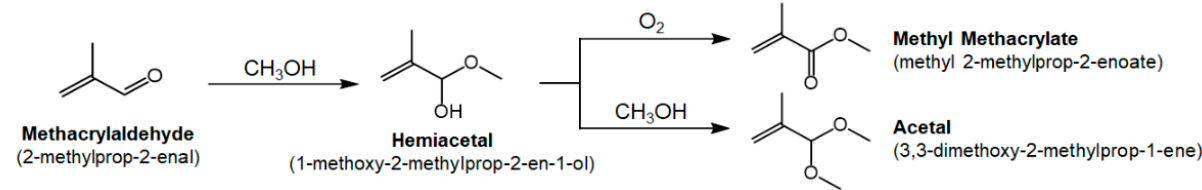
Figure 3. ( A ) X-ray diffraction patterns, ( B ) N 2 adsorption/desorption isotherms with pore size distributions (inset), and ( C ) CO 2 temperature-programmed desorption profiles of CeO 2 –Mg(OH) 2 after calcination at different temperatures: 450 °C (cyan), 600 °C (green), 750 °C (yellow), and 1000 °C (red). The N 2 adsorption isotherms showed that the CM(600) sample exhibited the highest porosity with a BET surface area (S BET ) of 128 m 2 g –1 and a total pore volume (V tot ) of 0.28 cm 3 g –1 (Figure 3B and Table 2). This sample showed a type IV isotherm, which indicates the presence of a mesoporous structure. As the calcination temperature was increased to 750 or 1000 °C, the BET surface area and total pore volume decreased very significantly (Table 2). Among the four samples with different calcination temperatures, CeO 2 – Mg(OH) 2 calcined at 600 °C (i.e., CM(600)) showed the highest porosity (Table 2). The crystallinities of the CeO 2 –Mg(OH) 2 samples also affected the surface basicity, as characterized by CO 2 TPD–MS (Figure 3C). The amounts of total basic sites (B T ) were proportional to the surface areas determined from the N 2 adsorption isotherms (Table 2).